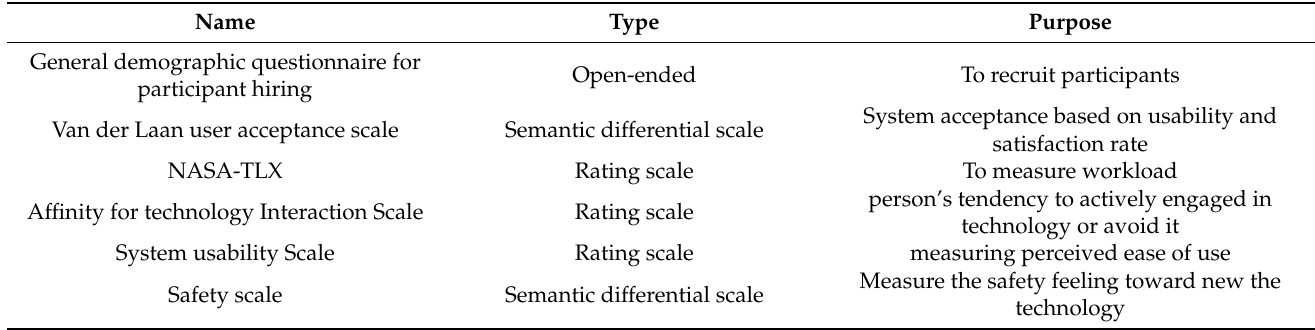
Table 1. The questionnaire used in the